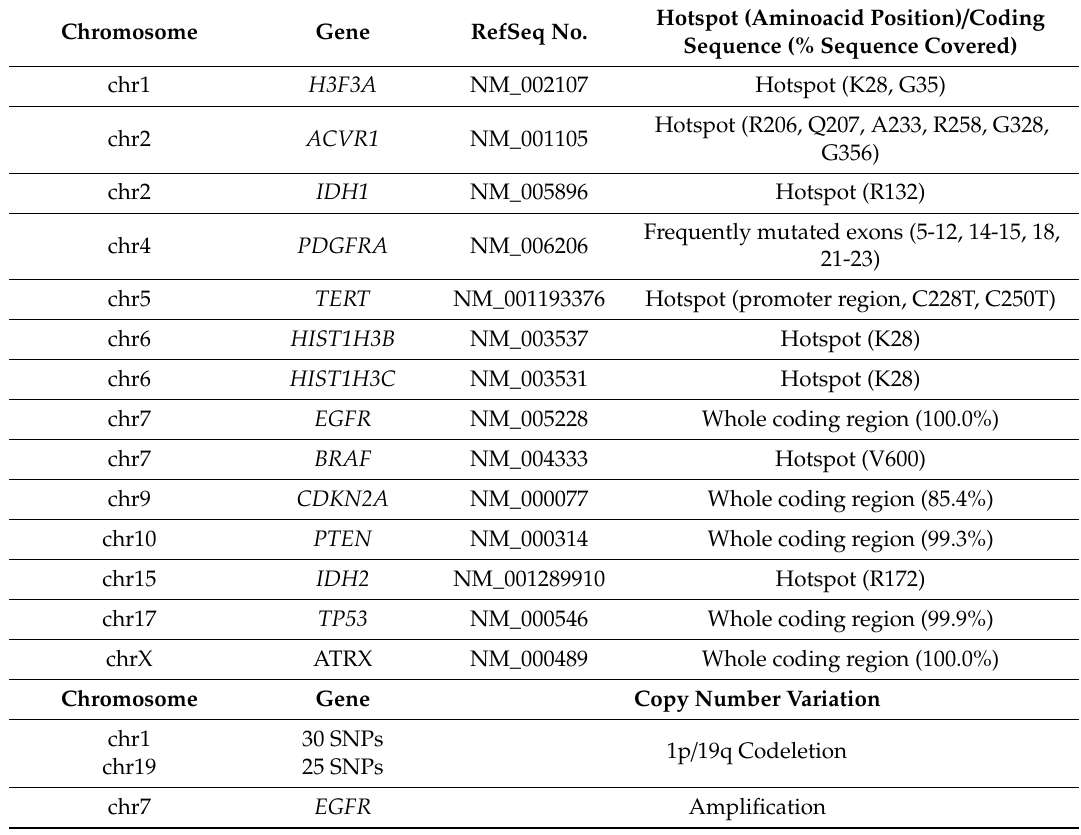
Table 2. Genes and regions tested in the glioma